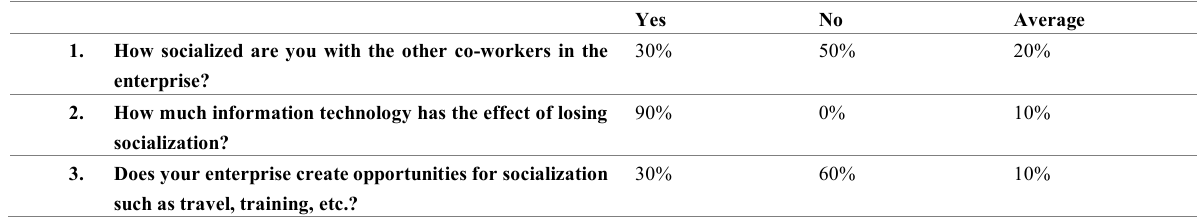
Table 3: The Impact of new technologies on employee